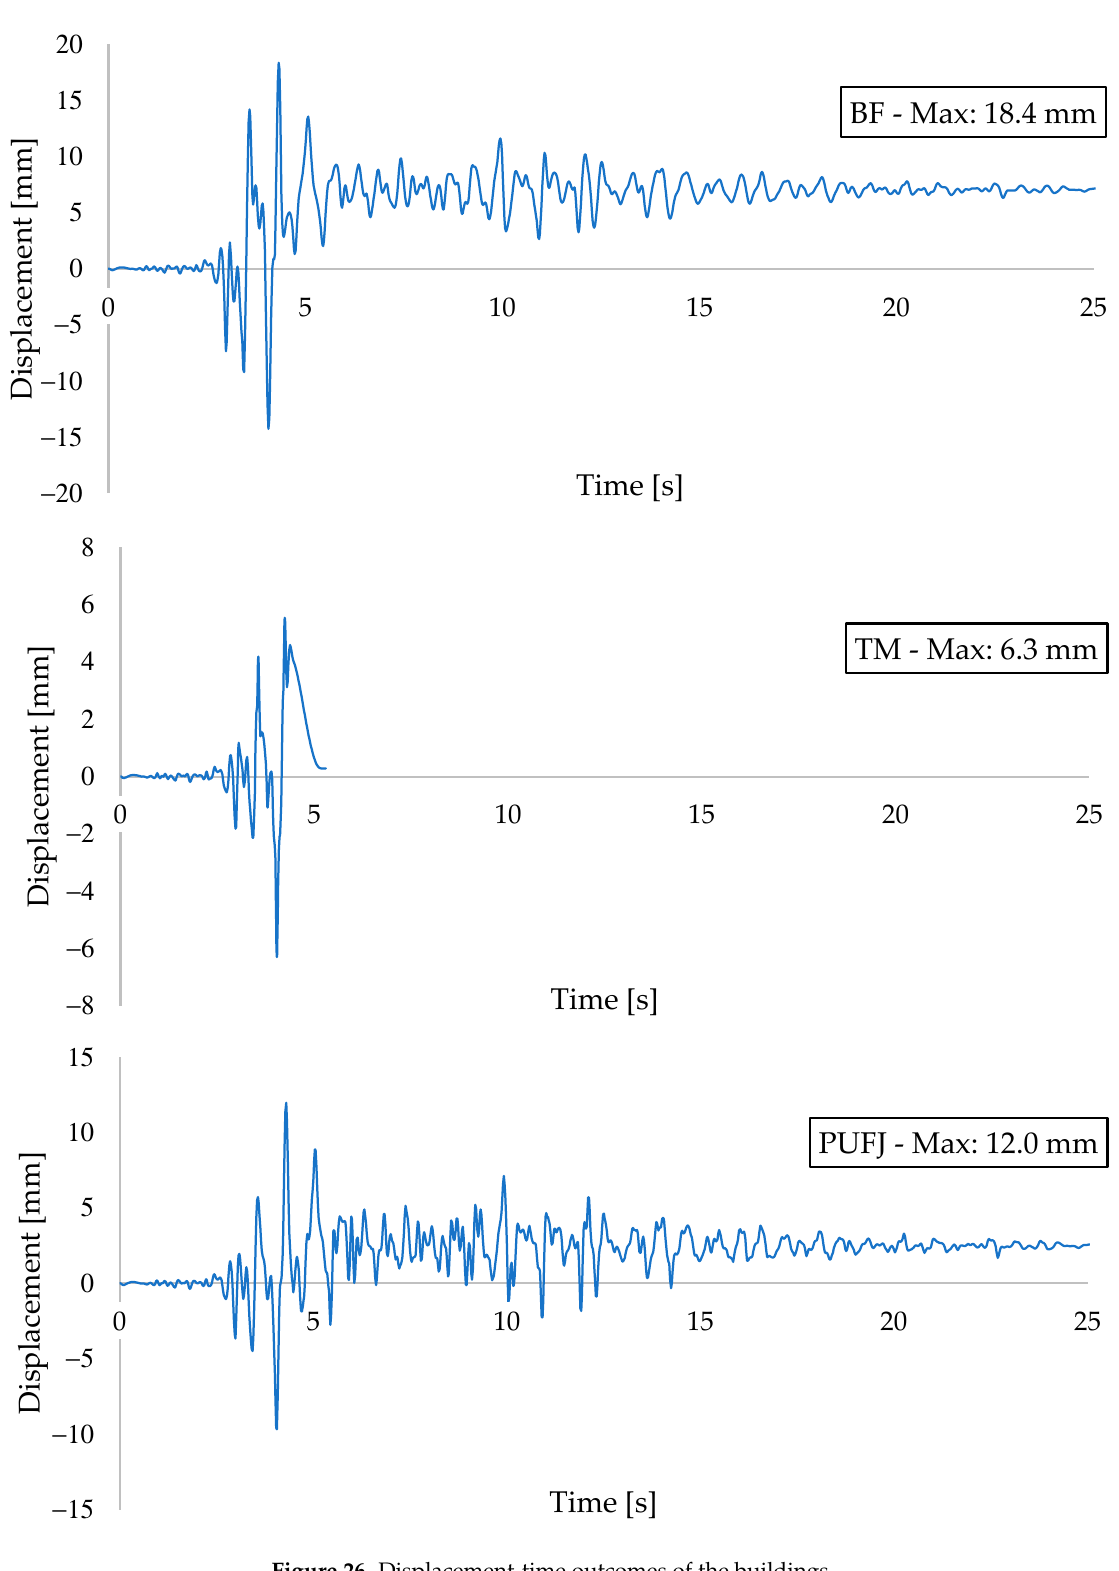
Figure 26. Displacement-time outcomes of the buildings.